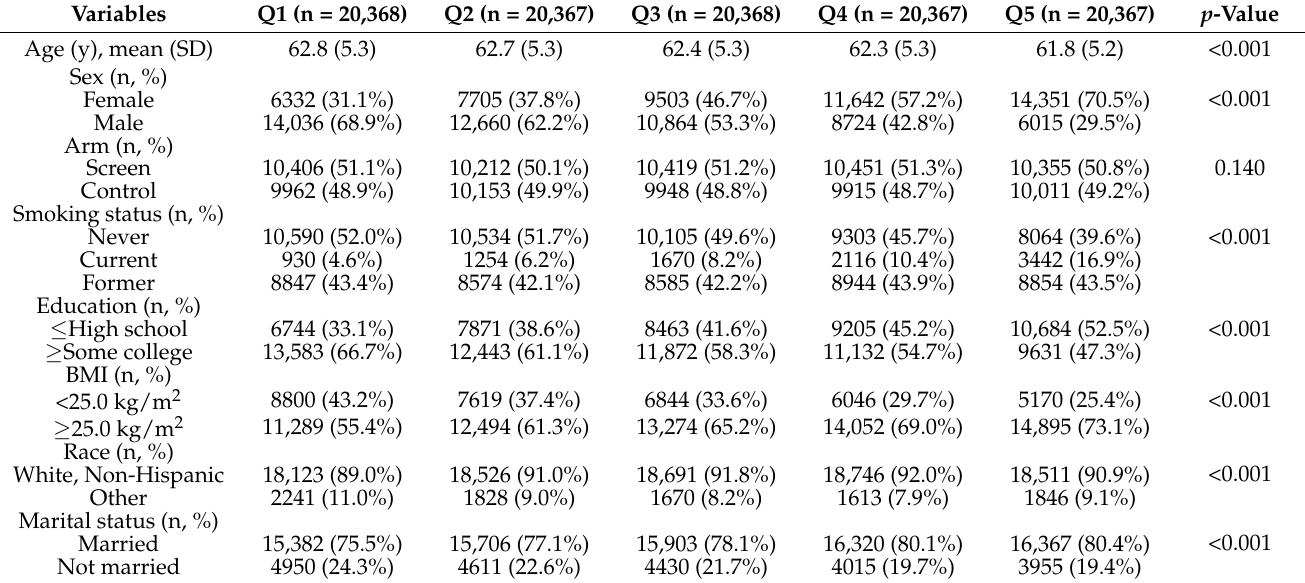
Table 1. Main characteristics of participants included in this study by E-DII from the Prostate, Lung, Colorectal and Ovarian (PLCO) Screening Trial, 1993 to 2001.